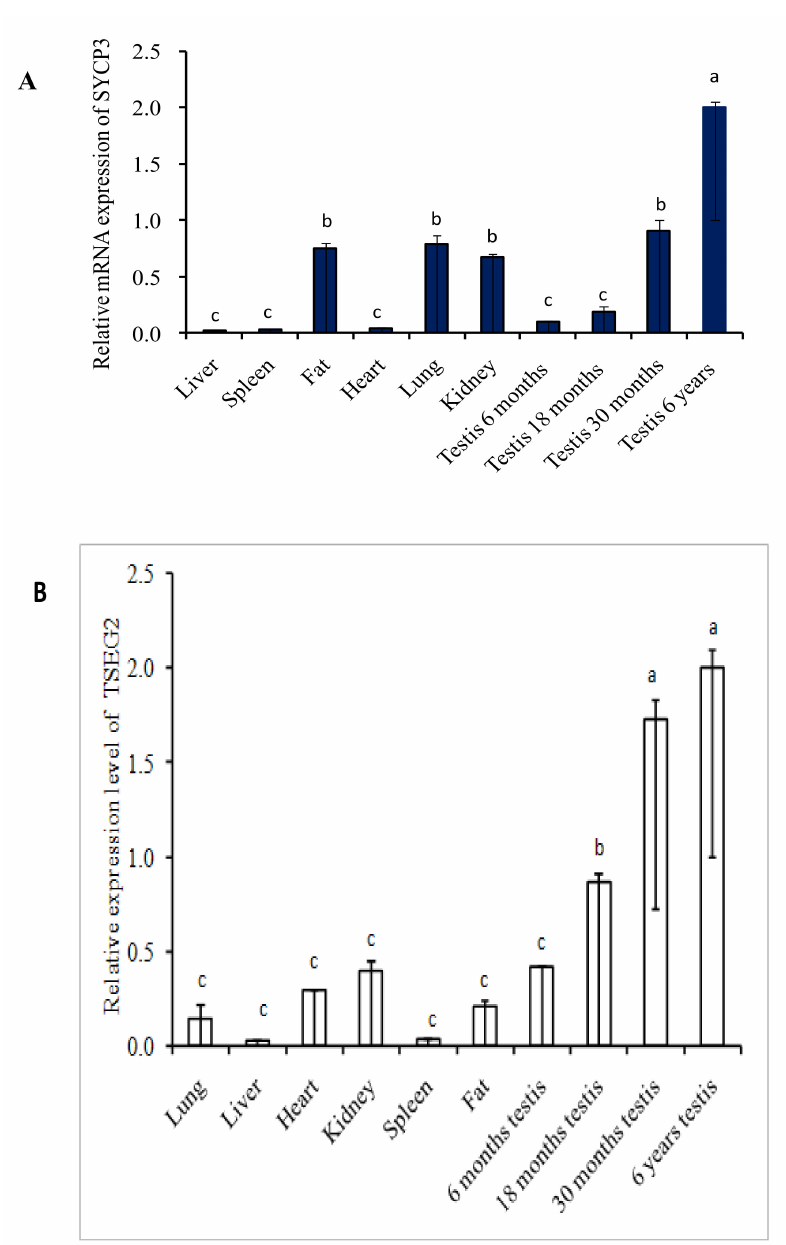
Figure 2. The quantitative real time PCR was used for assessment of the expression of SYCP3 and TSEG2 mRNA ( A ) SYCP3 ( B )